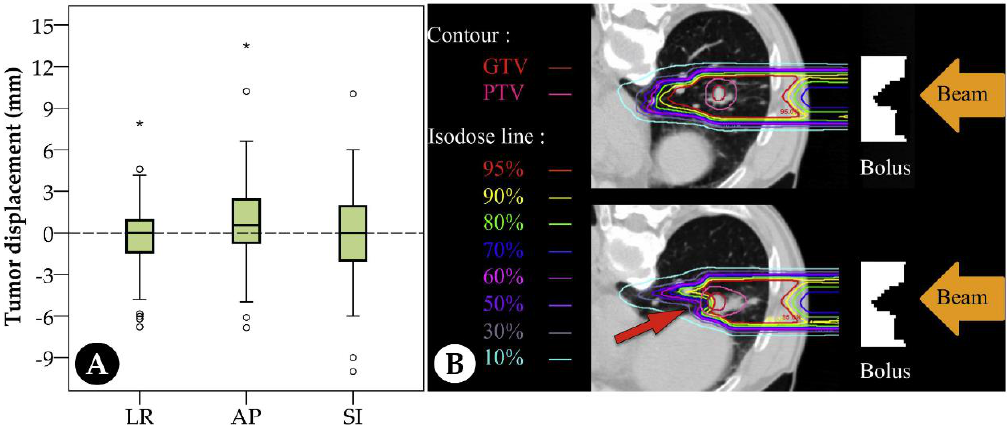
Figure 3. Tumor displacements of 50 patients with stage I lung cancer treated at Gunma University Heavy Ion Medical Center ( A ). * denotes the extreme value; ◦ denotes the abnormal value. Compared with original treatment plan (top), dose distributions significantly decreased due to internal anatomic changes in the simulation plan (bottom) ( B ). Figure 3B was adapted with permission from Irie et al. [8]. Abbreviations: LR: left–right; AP: anterior–posterior; SI: superior–inferior; GTV: gross tumor volume; PTV: planning target volume.